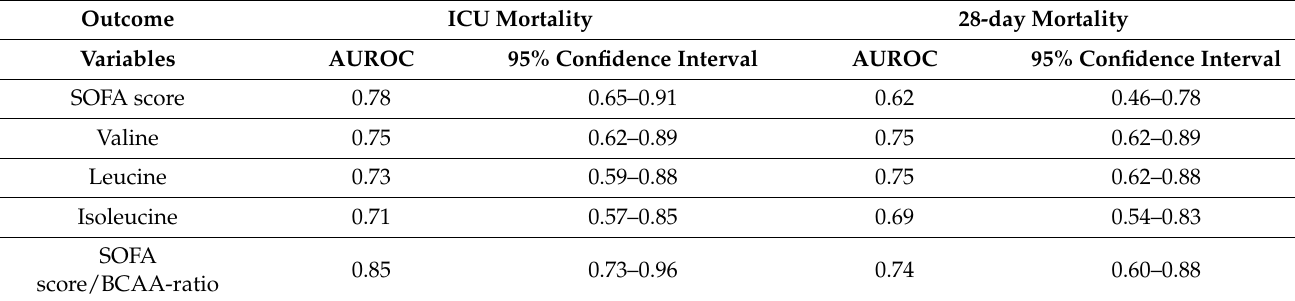
Table 7. ROC curves for 28-day and ICU mortality.